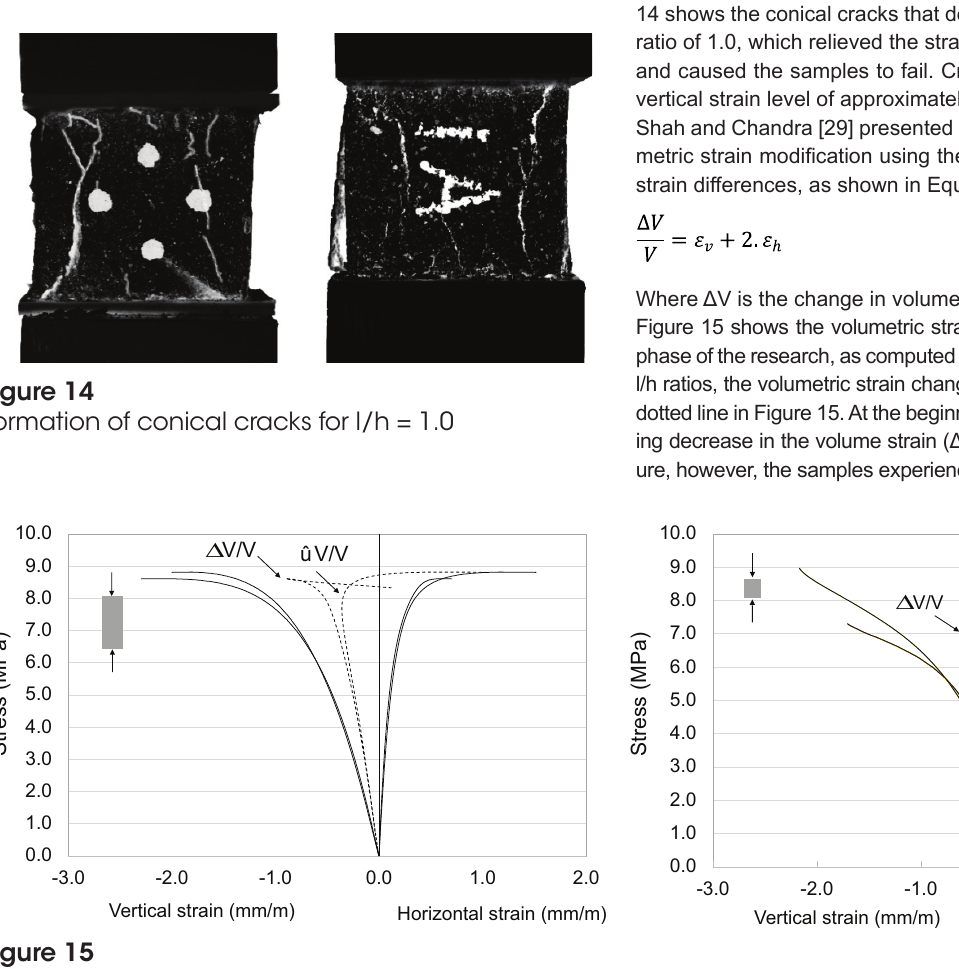
Volumetric strain for l/h values of 0.5 and